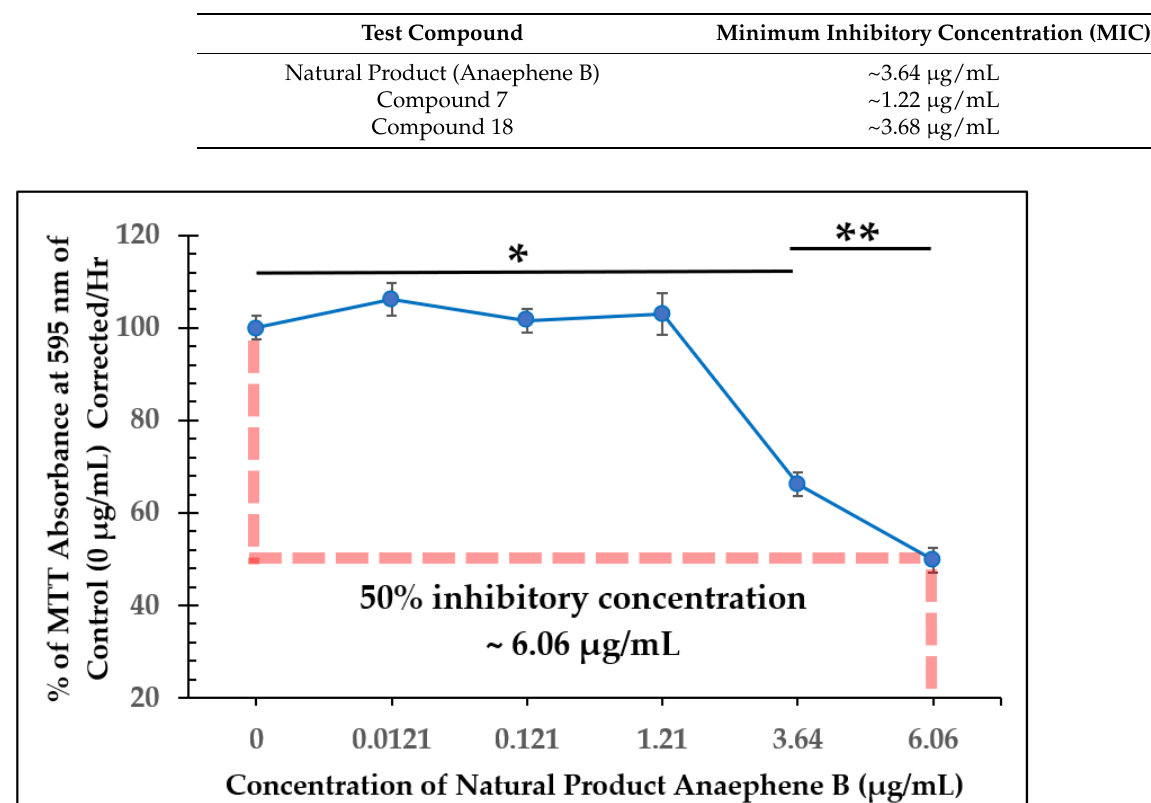
Figure 4. Dose-Dependent Effect of Natural Product Anaephene B on L. tarentolae . Additions at 100 h; Values are the mean and standard deviation for n = 4 replicates. Table 1. Minimum Inhibitory Concentrations (MIC) Observed for Anaephene B and Analogs Against L. tarentolae .